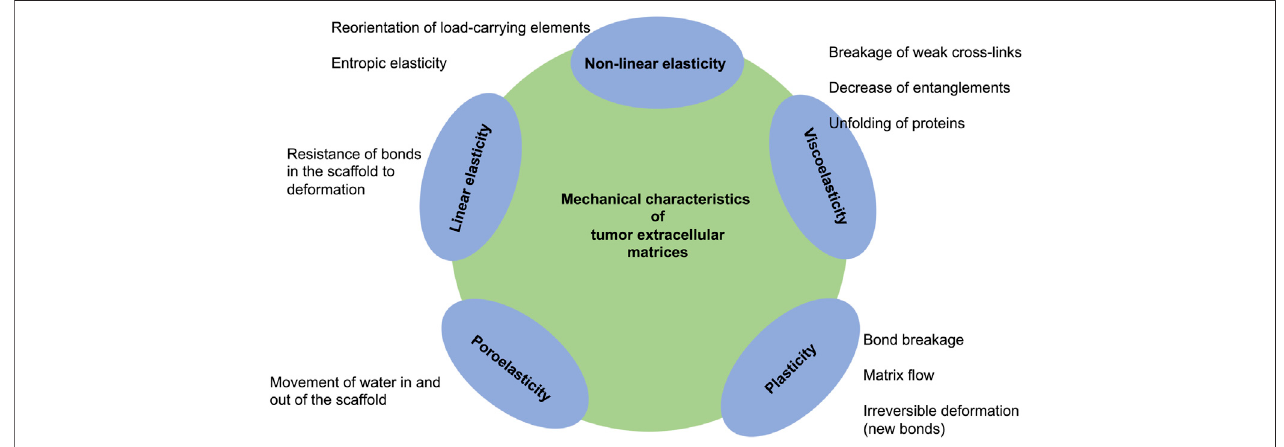
FIGURE 4 | Matrix features of tumor extracellular matrices and biological